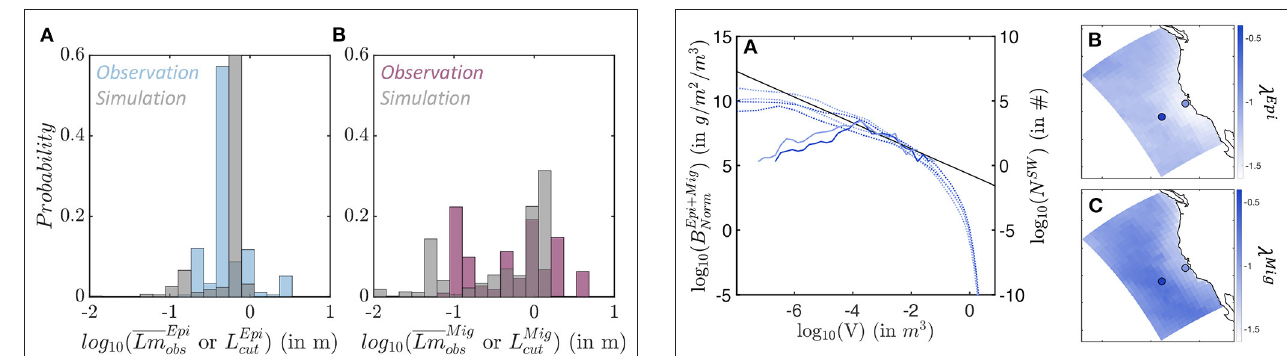
FIGURE 7 | Species size distributions. (A) Observed average species size per trawl Lm Epi obs (blue) and simulated maximum size per grid cell (gray) for the epipelagic community L Epi cut . (B) Observed average species size per trawl Lm Mig obs (purple) and simulated maximum size per grid cell (gray) for the migratory community L Mig cut .